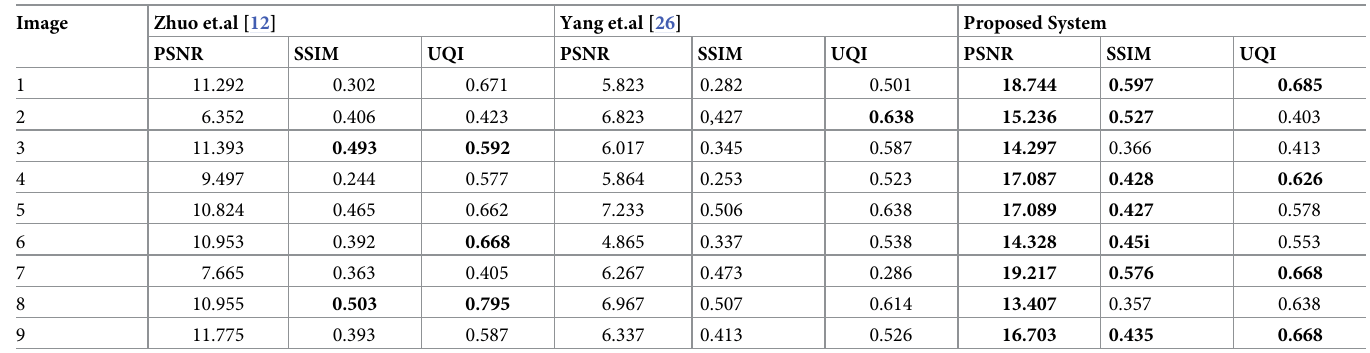
Table 2. Comparison parameters PSNR, SSIM and UQI using dataset